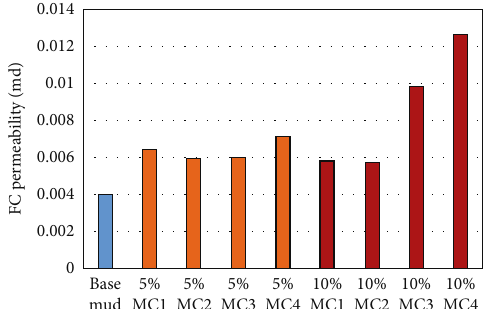
Figure 14: Filter cake permeability as function of adding di ff erent cuttings to the base